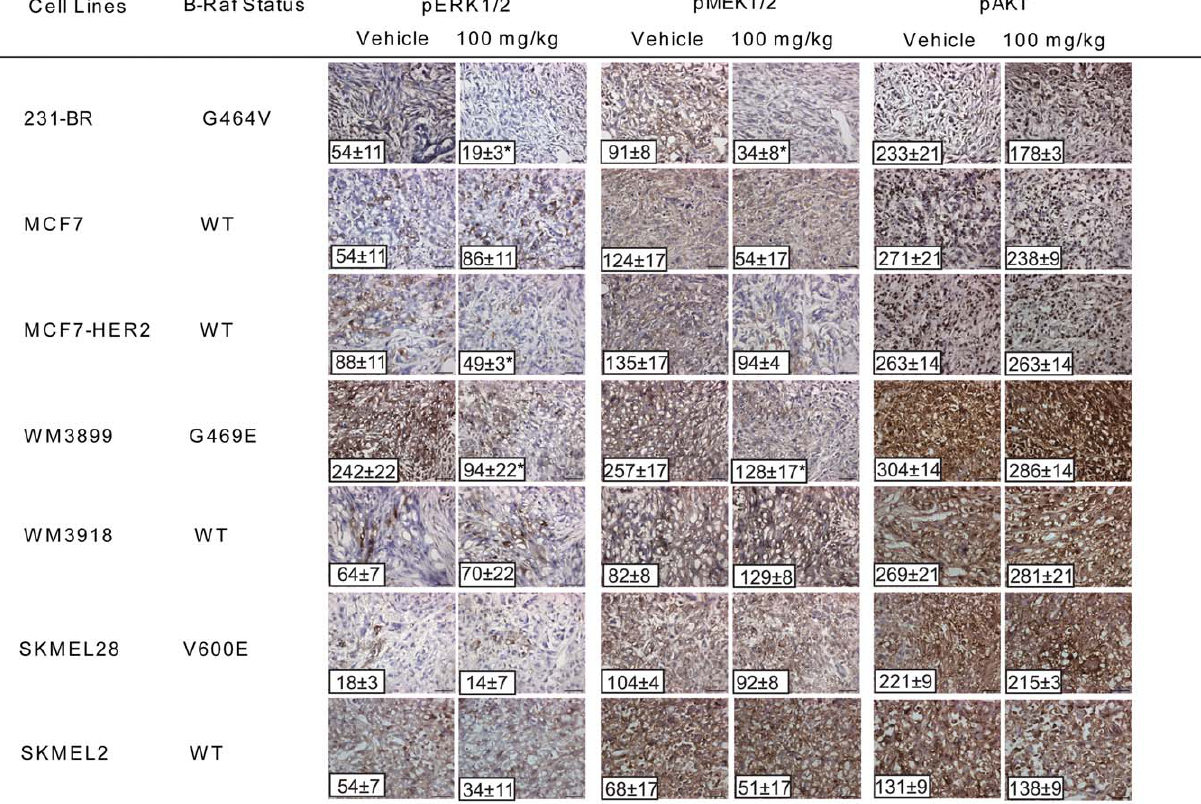
Figure 4C and Figure S4 present representative photographs of CD31 staining.